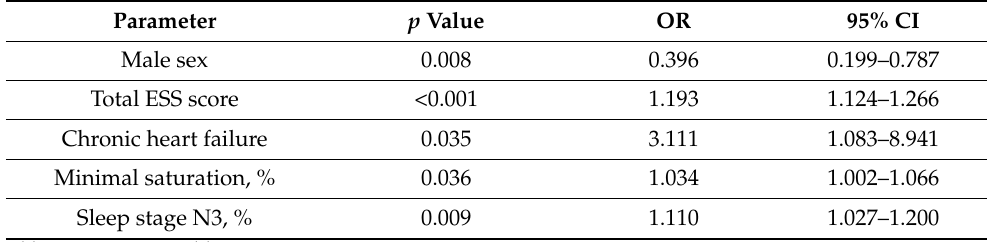
Table 4. Multivariate logistic regression analysis of significant predictors of poor sleep